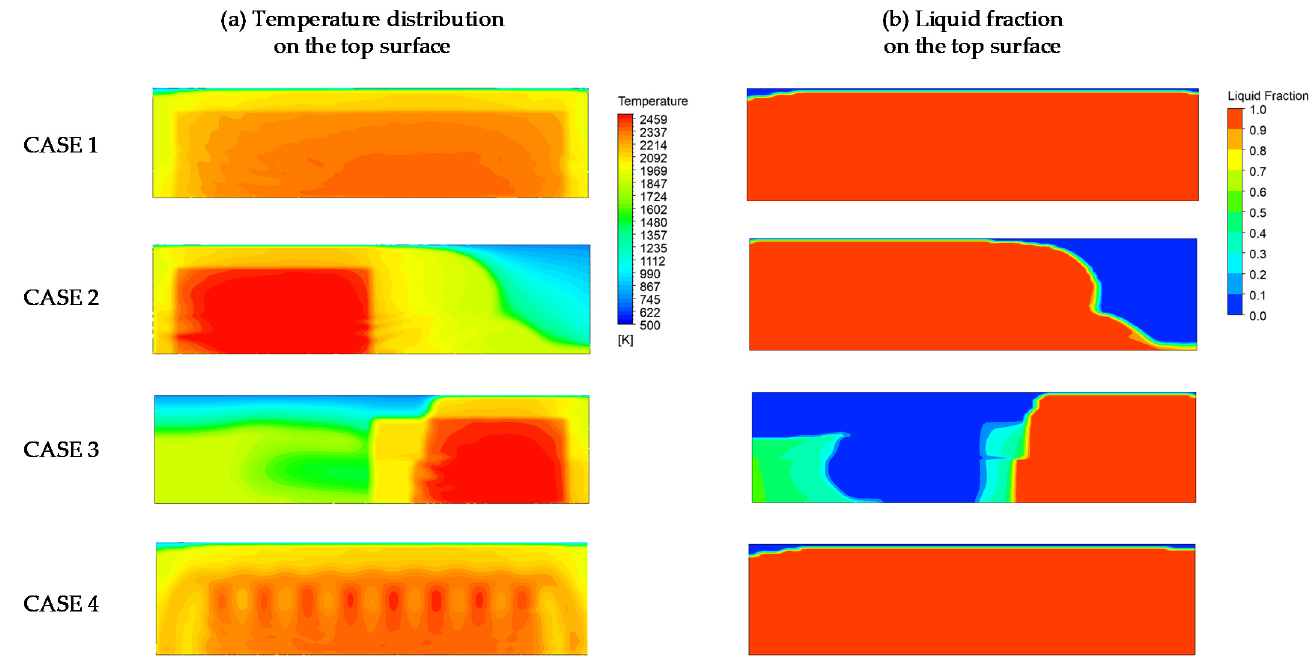
Figure 8. ( a ) Temperature fields and ( b ) liquid fractions under the four scanning strategies in the water-cooled hearth.